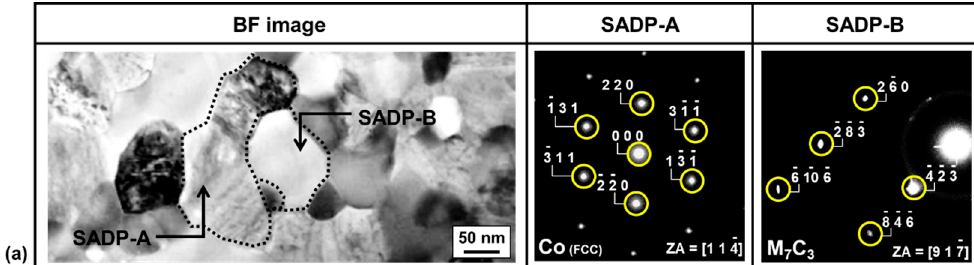
Figure 11. ( a ), ( b ) BF images and EDS results of laser heat treated Stellite-1 coating at 1473 K.